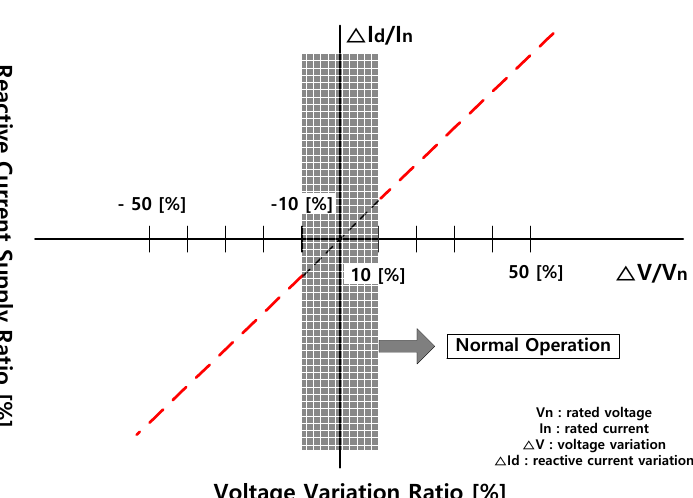
Figure 6. The reactive power supply